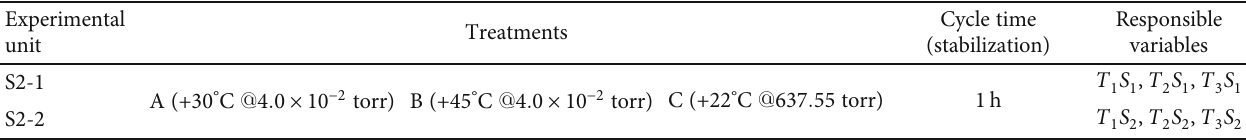
Table 4: Detail of the treatments applied to experimental units, the stabilization cycles, and the response variables.